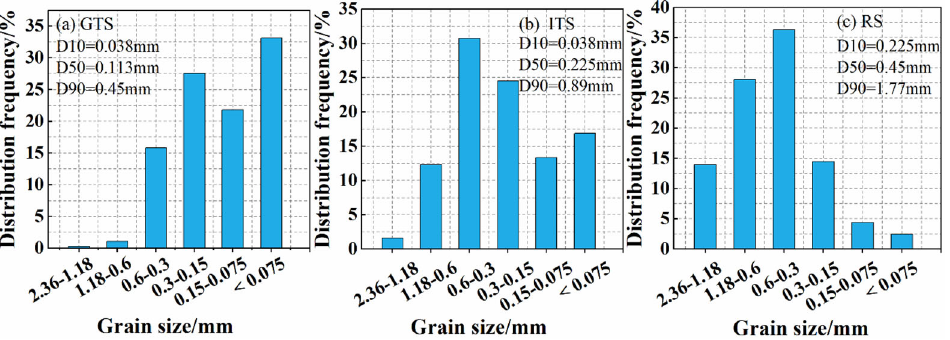
Figure 4. Size distributions of different fine aggregates ( a ) GTS, ( b ) ITS, ( c ) RS. Table 3. Physical characteristics of fine aggregate.